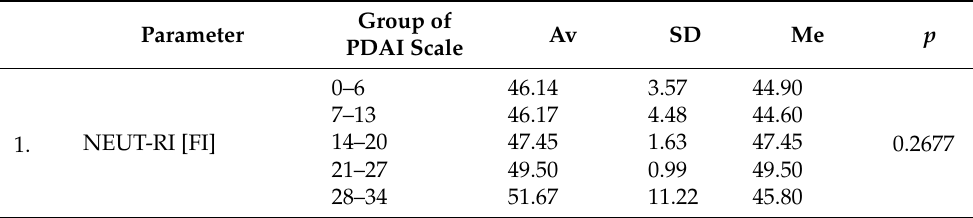
Table 4. Dependence of selected parameters on the extent of skin and/or mucosal lesions (according to the PDAI scale) during pemphigus